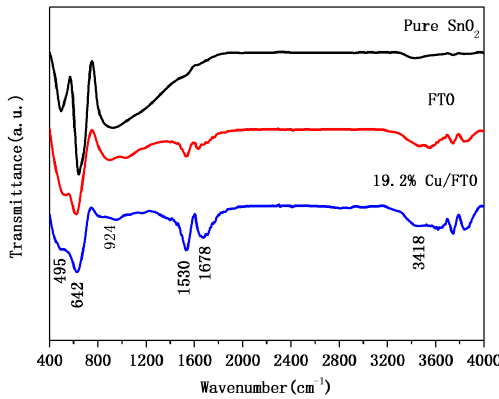
Figure 2. FTIR (Fourier transform infrared spectroscopy) spectra of pure SnO 2 , FTO, and Cu/FTO samples.